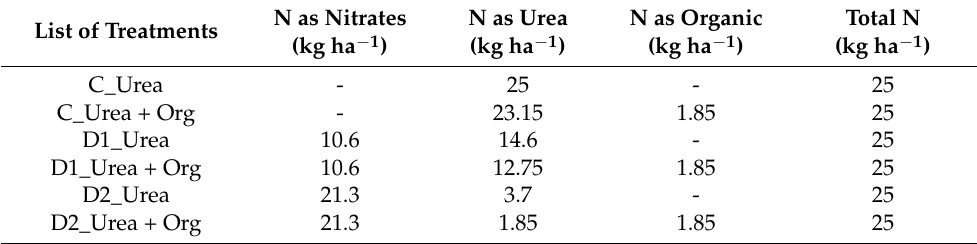
Table 2. List of treatments with the amount of N (Kg ha − 1 ) and chemical form applied, together with cations by foliar spraying, and reference